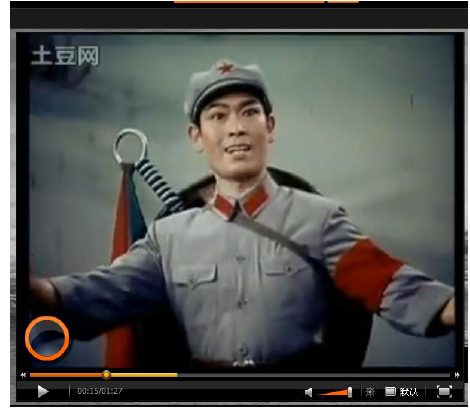
Figure 5: Example of a “Red Army Choir sings...” video, on Tudou, featuring the television theme song for the animated series of “Teenage Mutant Ninja Turtles.” Screenshot taken on November 22,